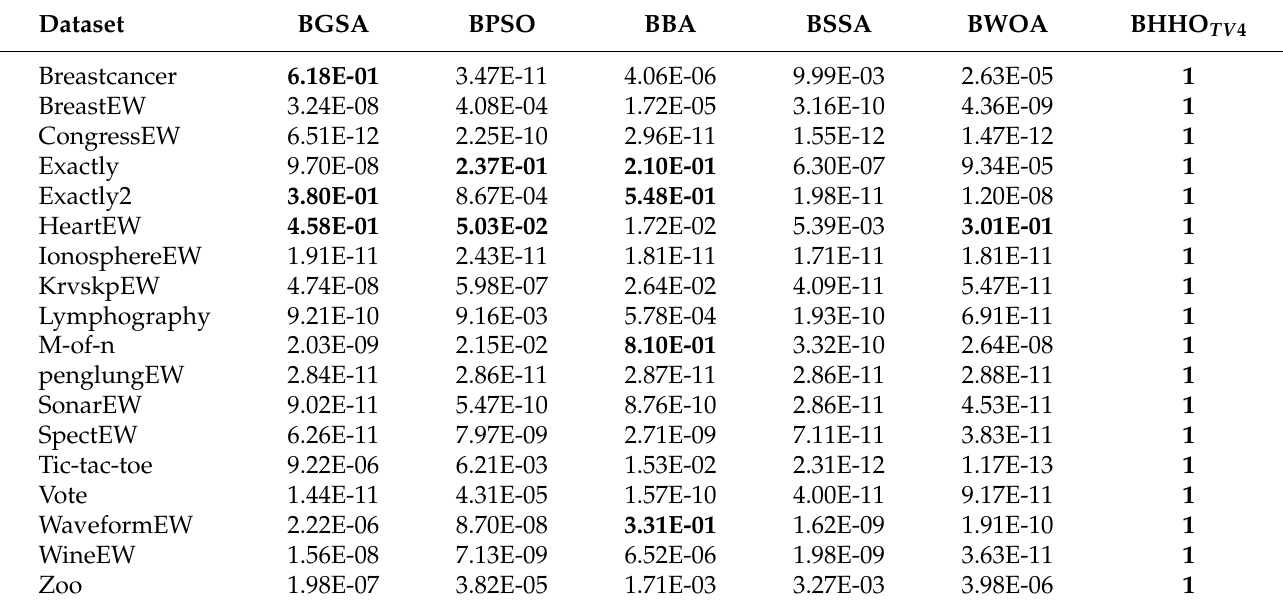
Table 10. The 2-tailed p -values of the Wilcoxon signed ranks test for the number of features reported in Table 9 ( p -values ≤ 0.05 are significant).